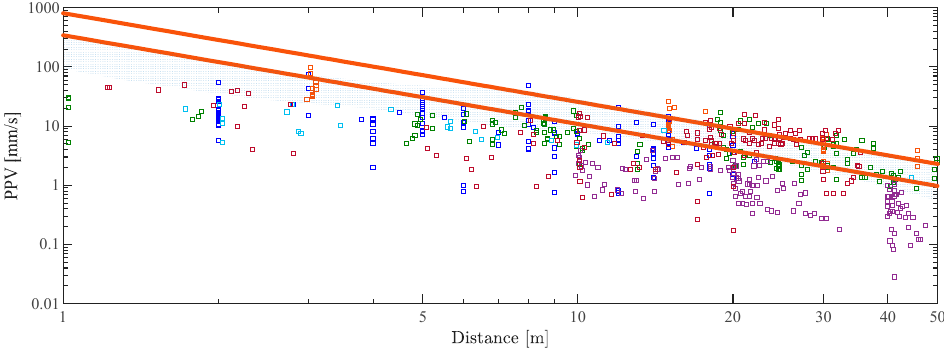
Figure 16. Comparison of the PPV results provided by experimental measurements, numerical modeling and empirical approaches (blue shade—envelope of the numerical results using an equivalent linear approach; green shade—envelope of the numerical results using a linear approach; red curves—FTA empirical approach).